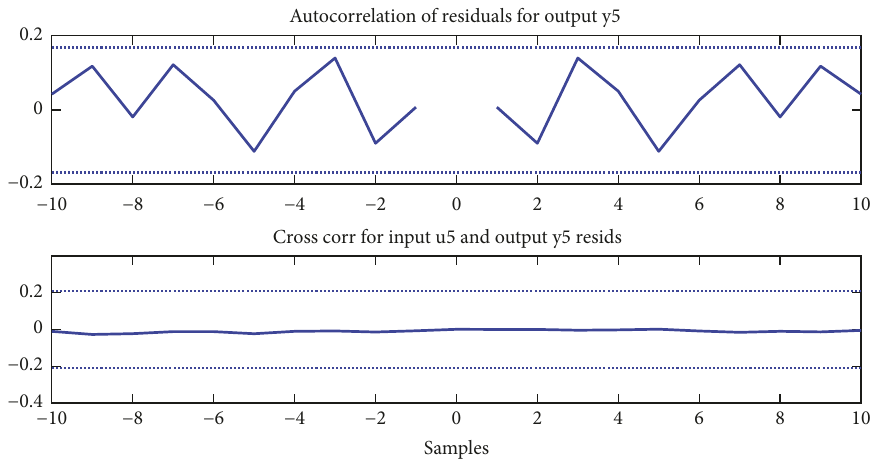
Figure 28: Autocorrelation y5 and cross-correlation of system responses u5 & y5.